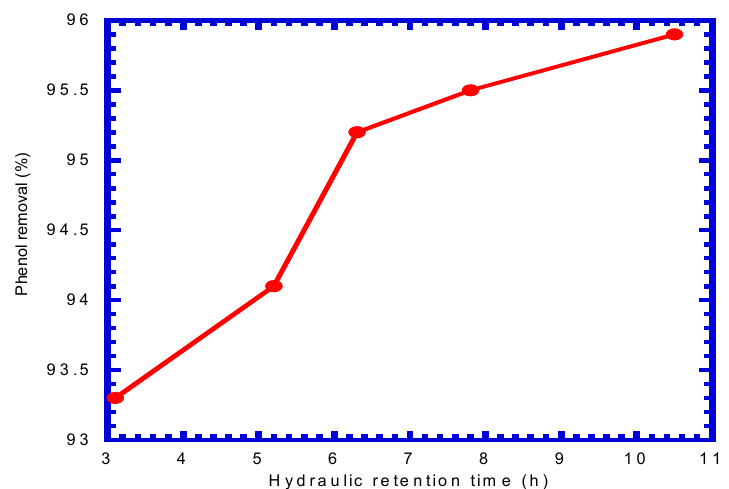
Figure 10. Influence of hydraulic retention times on phenol removal in the continuous